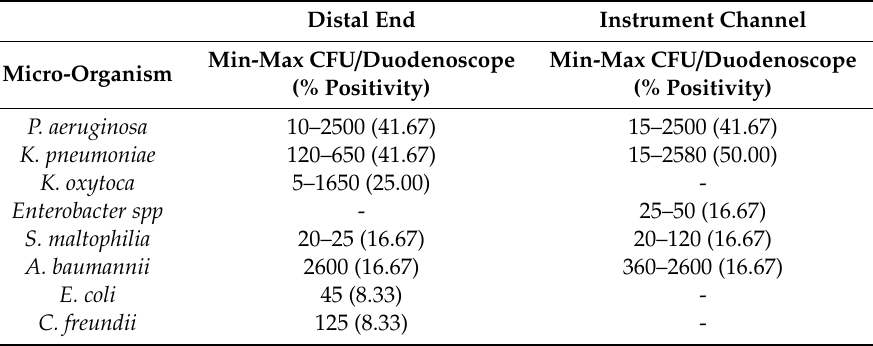
Table 1. Minimum and maximum concentrations of high-concern microorganisms (CFU / duodenoscope) and percentages of positivity of samples taken from the distal end and the instrument channel of the